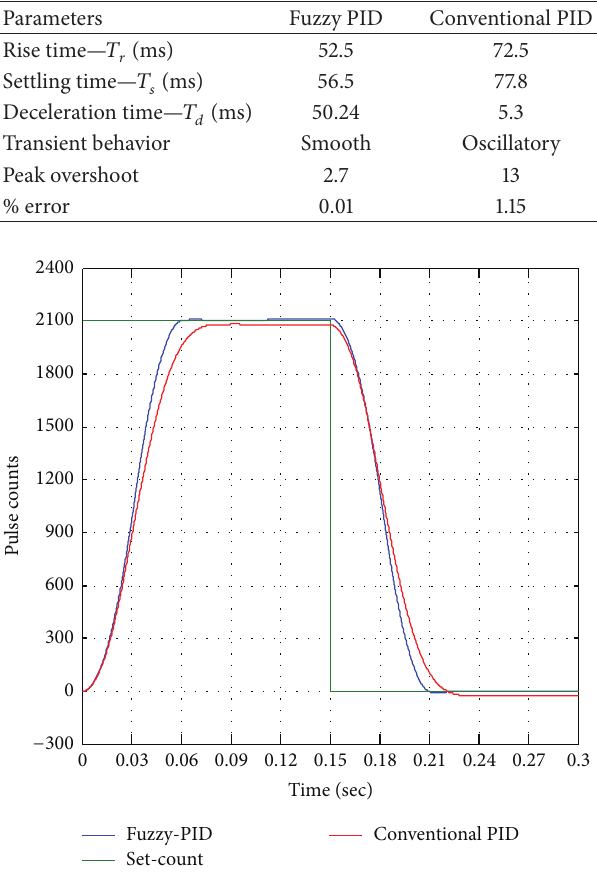
Figure 17: Step change from 2100 to 0 pulse